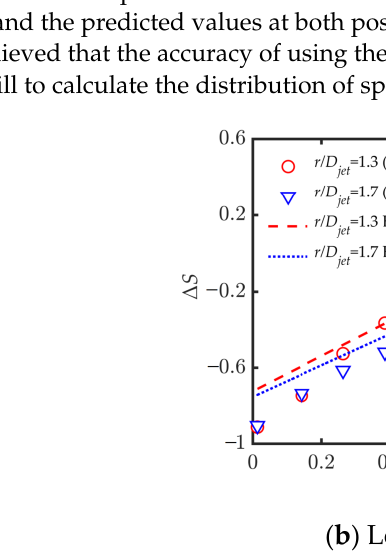
Table 4. Speedup ratio of different slopes.